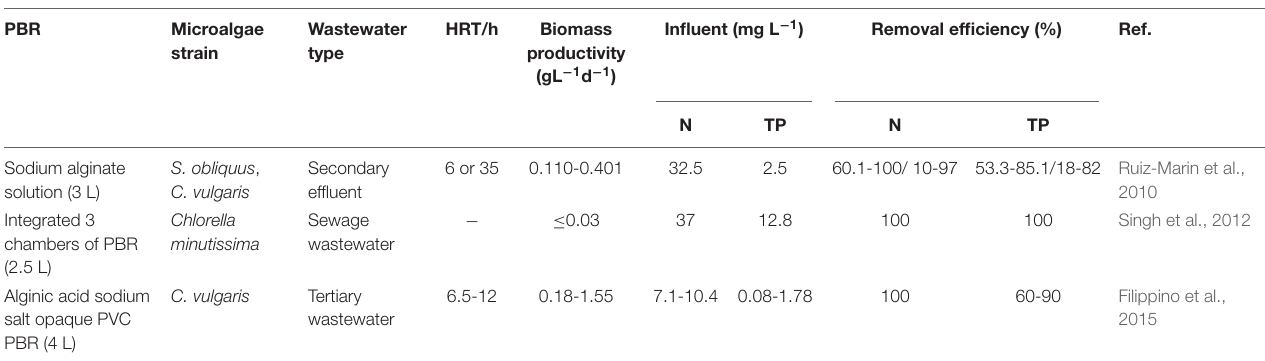
TABLE 3 | Microalgae-based immobilized bead systems for wastewater treatment (Ting et al., 2017).